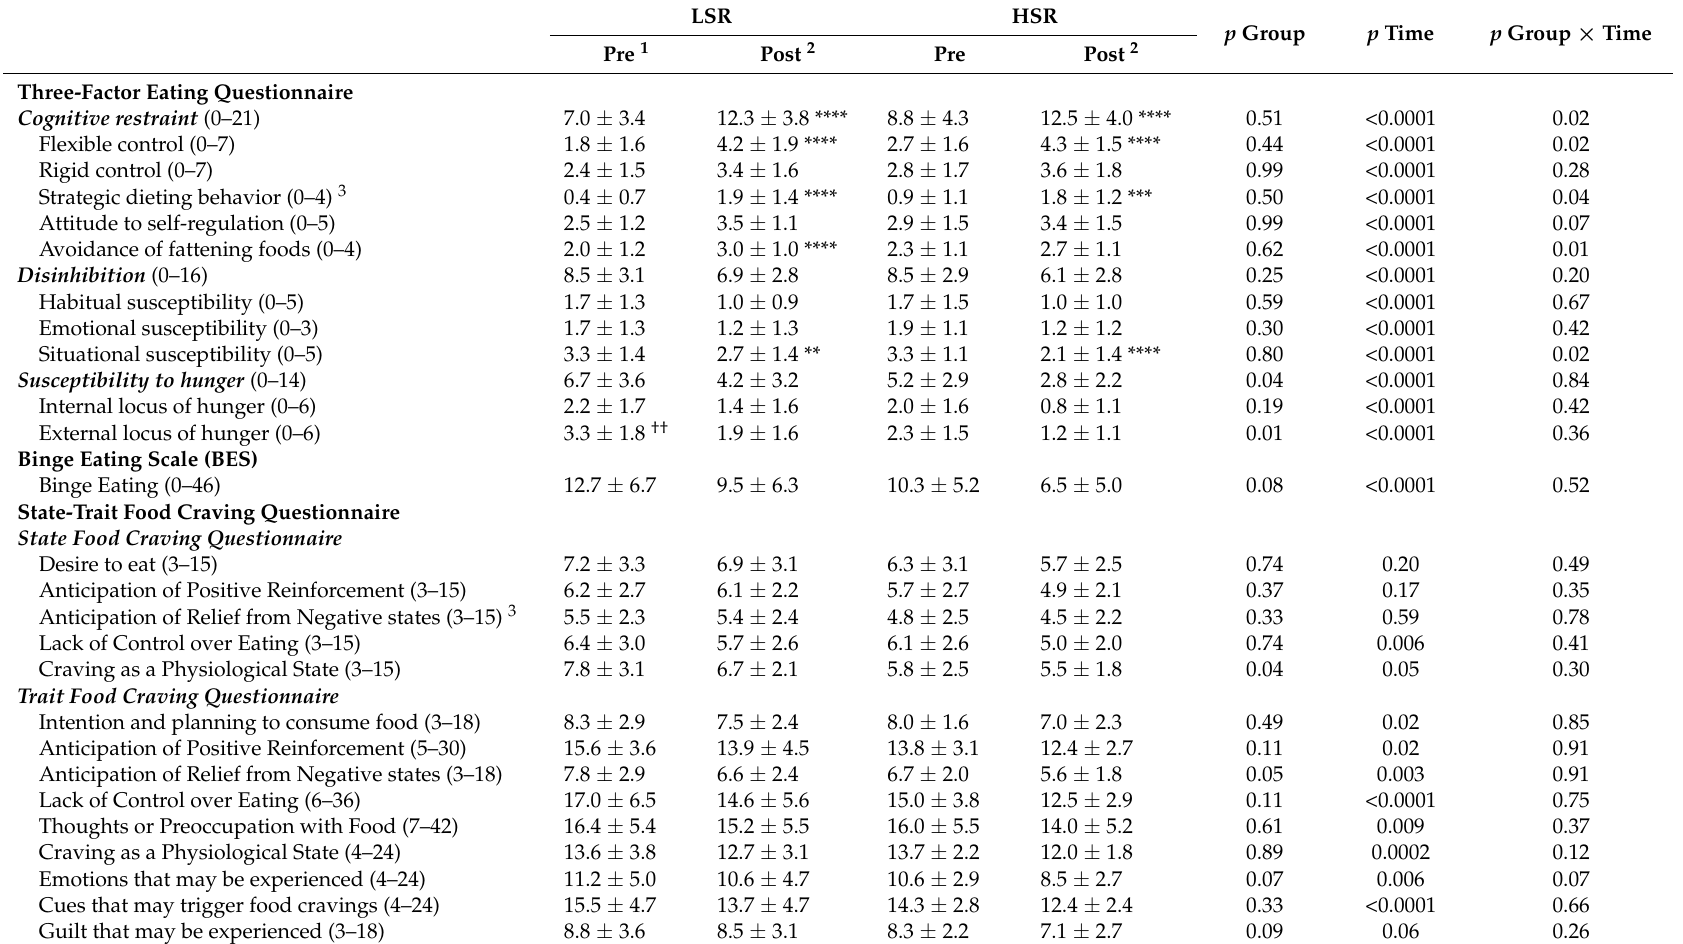
Table 3. Eating behavior traits and psychobehavioral factors at baseline (pre) and after weight loss (post) in the LSR and HSR